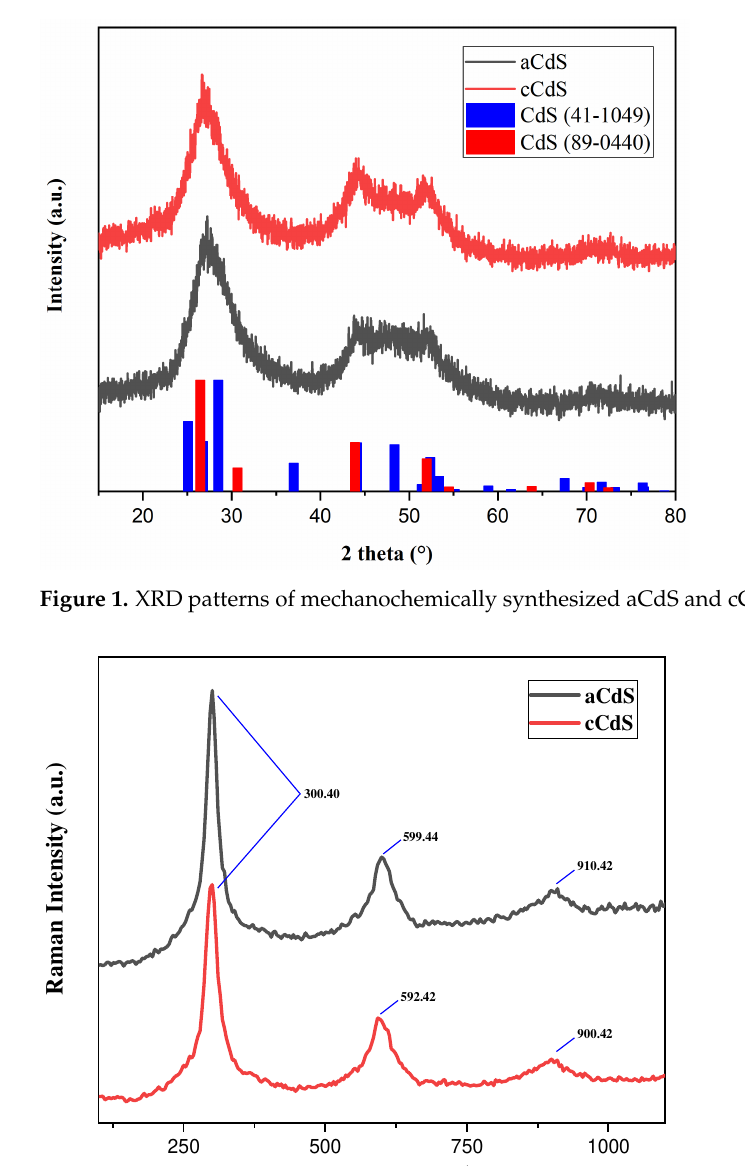
Figure 1. XRD patterns of mechanochemically synthesized aCdS and cCdS samples.